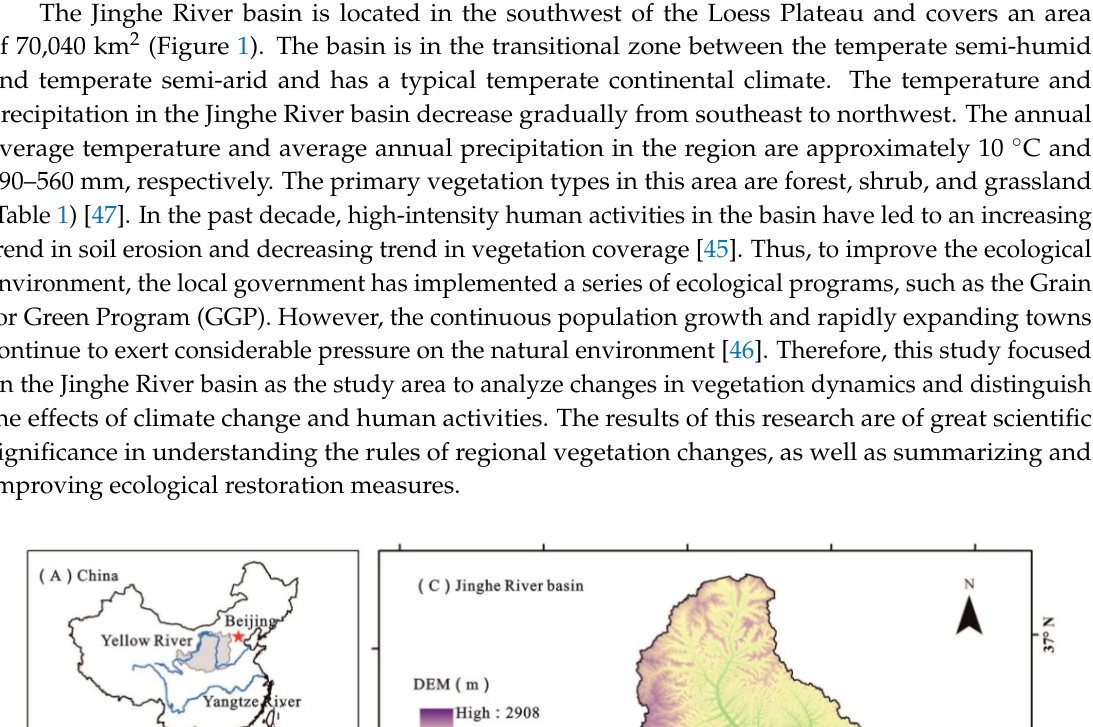
Table 1. The land use types in percentage terms in the Jinghe River basin (Unit: %). Land Use Types Forest Shrub Grassland Farmland